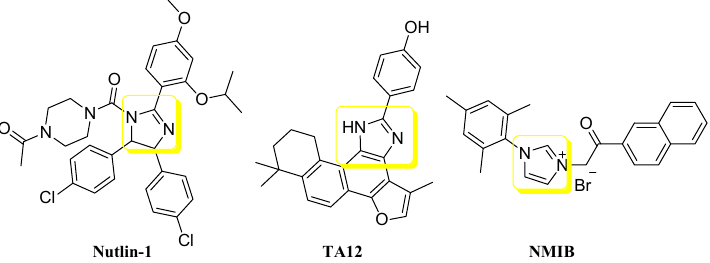
Figure 1. Representative structures of imidazole derivatives possessing antitumor activity.